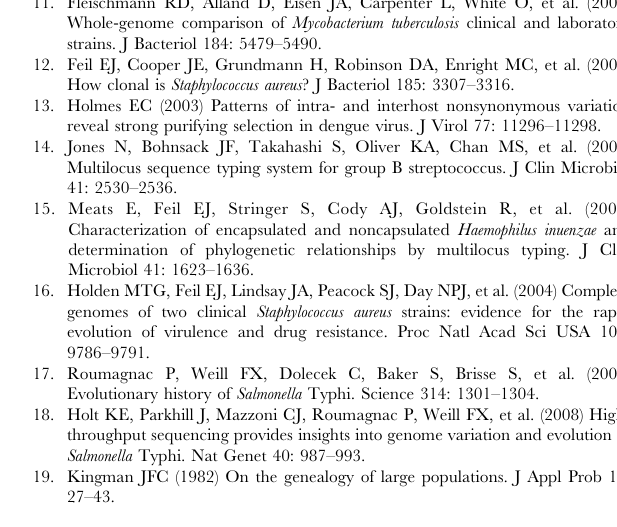
Figure S1 The relationship between the selection coefficient, c , and the dN/dS ratio in simulated Wright-Fisher populations for h =0.1. Mutations are artificially switched off whenever two alleles segregate in the population. Notations as in Figure 2. Figure S2 Stationary frequency distribution of the mutant allele for the Wright-Fisher model with continual selection. Gray bars show the histrogram obtained from the two-allele simulations with h =0.1, squares represent the corresponding values expected from Equation (4). Top panel, c = 2 3, bottom panel, c =3. Insets show the same data on a different scale. Found at: doi:10.1371/journal.pgen.1000304.s002 (0.4 MB